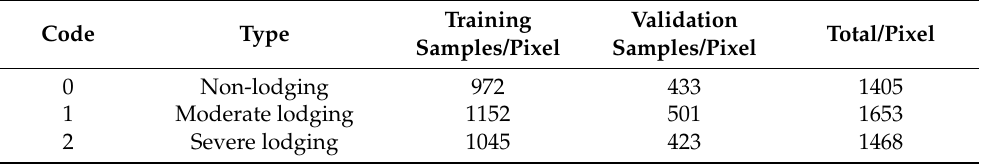
Table 3. Number of training and validation samples used for machine learning.